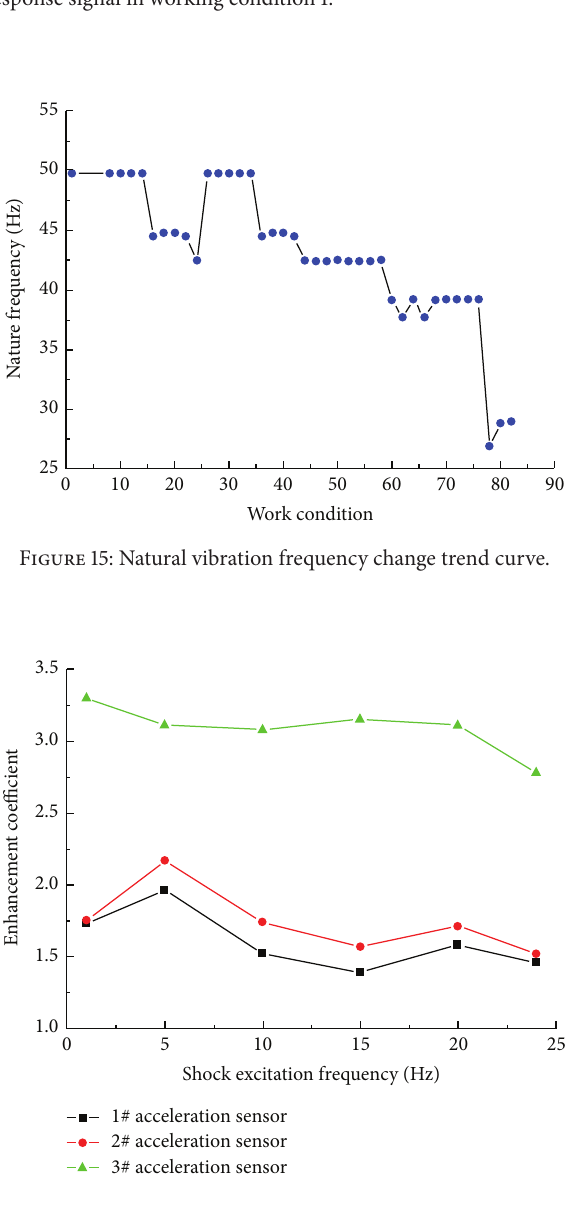
Figure 16: Enhancement coefficient curve of the acceleration response (0.02 g).